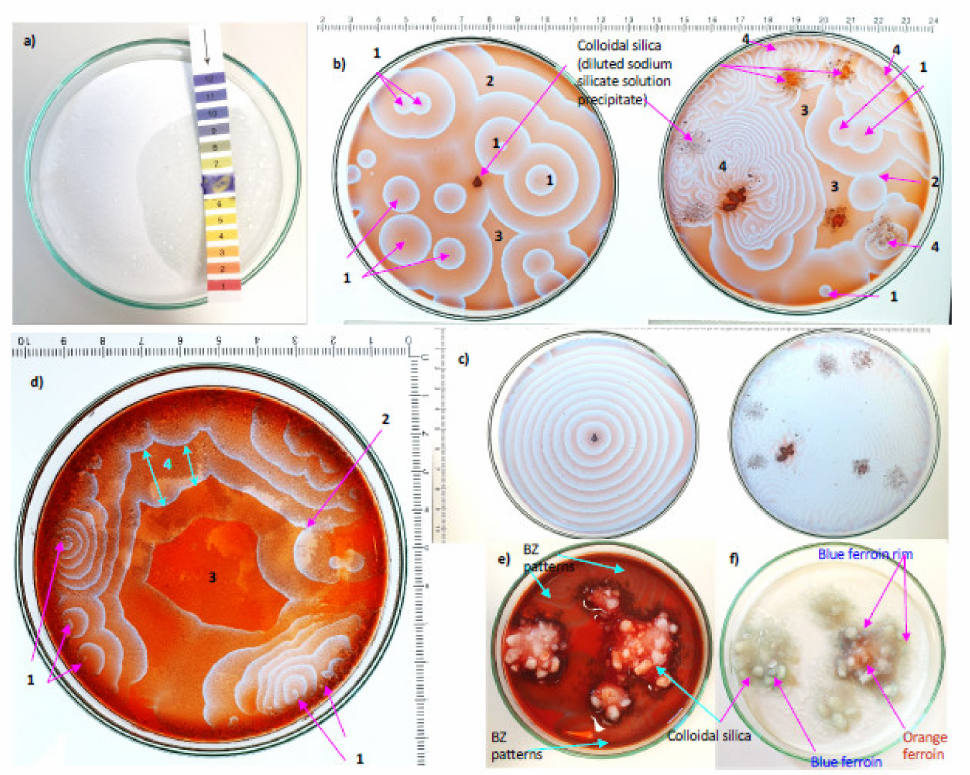
Figure 4. Chemically oscillating reactions in a Petri dish enriched with colloidal silica. Area of uniformly distributed colloidal silica rehydrated with DI water has an alkaline pH of more than 12, as seen on the indicator strip. ( b ) Classical B-Z reaction with the addition of colloidal silica particles near the centre of the Petri dish. One spatula full of silica scattered throughout the right dish. Both dishes feature point centre oxidation spots (1) and open book features (2) from destructive interference of circular waves along with cavities (3). ( a ) On the dish to the right with more silica, spirals form (4) with high frequency oscillations, while the waves become irregular. Note the occurrence of spirals in proximity to the silica. ( c ) Duplicate reactions from “b)” after 40 mins. Note that the colour of ferroin is mostly blue after so long and the strong colour gradients. The left dish is dominated by a single oxidation spot with low frequency oscillations that originate from the central silica particle. The right dish shows the solution is mostly blue with high frequency oscillations self-similar